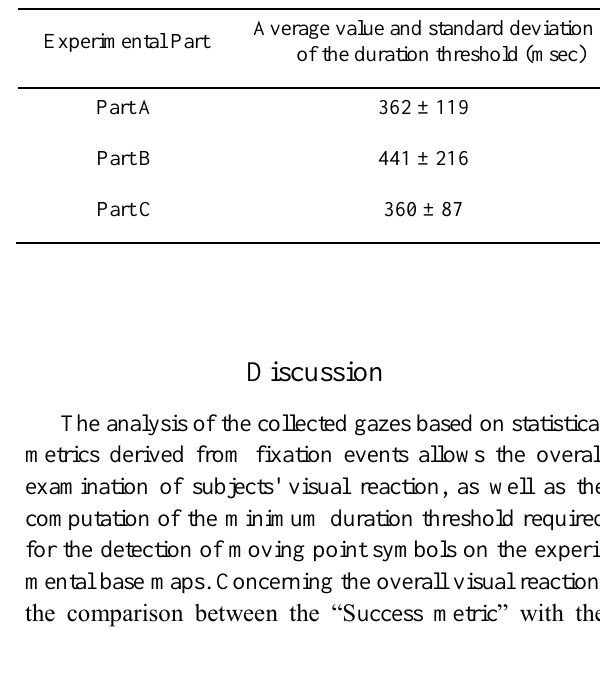
Average value and standard deviation of the duration threshold (msec) for all experimental